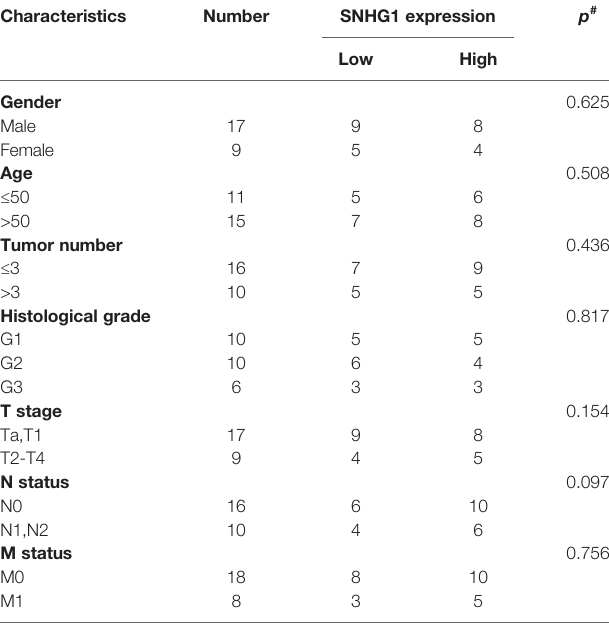
TABLE 1 | The associations of SNHG1 expression with clinical pathologic features in patients with bladder cancer.